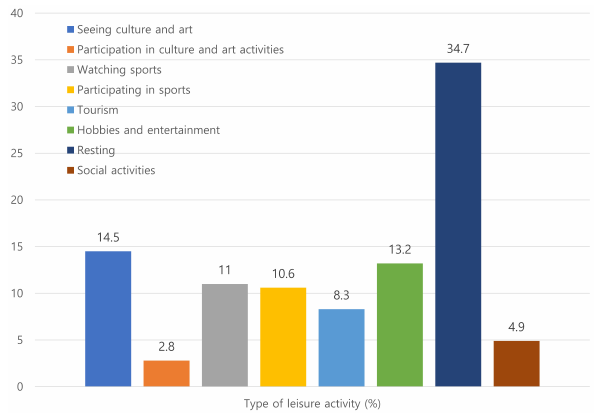
Fig. 5. Type of leisure activity of study participants.